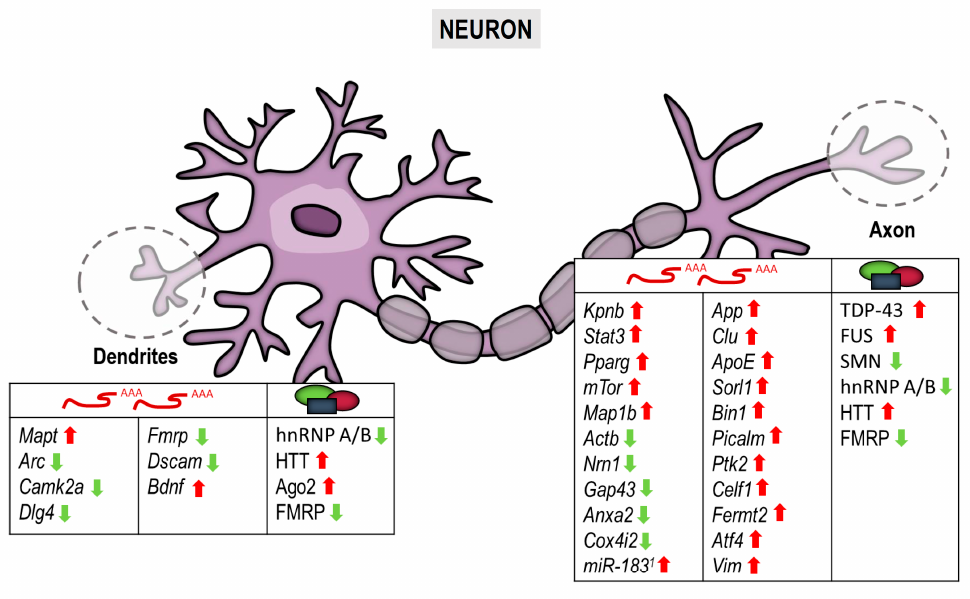
Figure 2. Neurite-localized transcripts and RBPs affected in pathological conditions. Note that some mRNAs and RBPs depicted differ between dendrites and axons. 1 Indicates miR-83 which is not an mRNA but a microRNA, yet it is localized to axons and regulates local protein synthesis [12]. Arrows indicate altered levels (red, increase; green, decrease) of mRNAs and/or proteins in diseases.